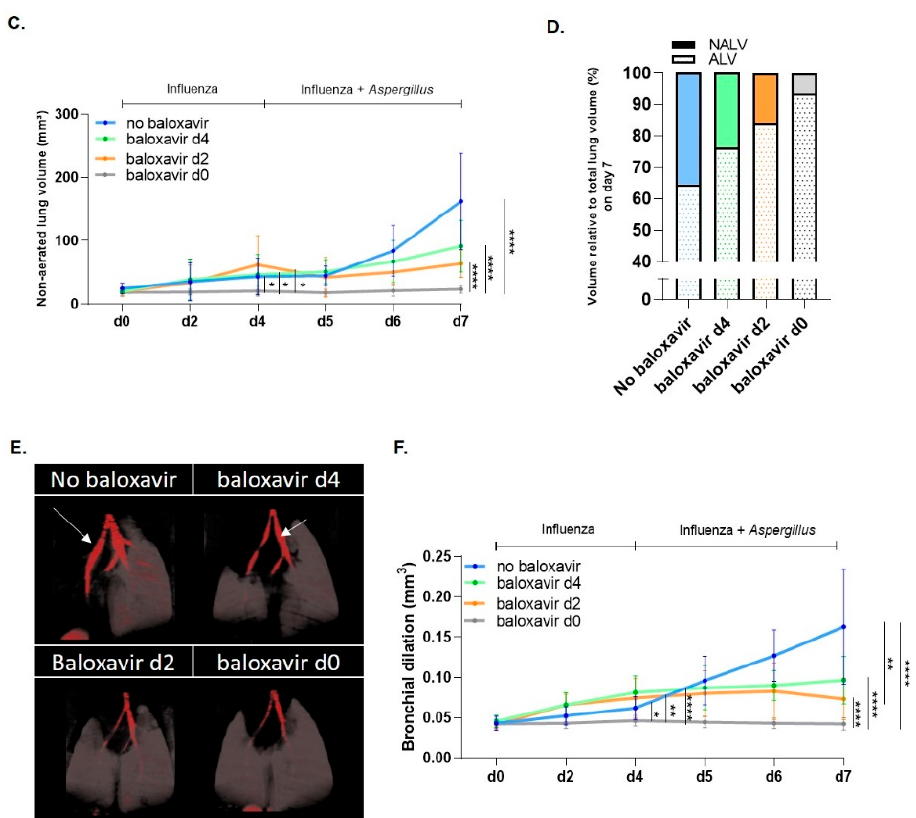
Figure 2. Baloxavir marboxil treatment reduces viral and viral-fungal pulmonary pathology and bronchial dilation. ( A ) Longitudinal three-dimensional (3D) visualization of aerated lung volume acquired with µ CT. Red: aerated lung tissue, Black arrows point at pulmonary infiltrates/lung pathology and dashed arrow to bronchial dilation. ( B ) Heatmap representation of lung severity scores based on transverse lungs µ CT images of non-treated (sham, no baloxavir), baloxavir marboxil from day 4, baloxavir marboxil from day 2 and baloxavir marboxil from day 0 treated mice. Red: severe pulmonary lesions, orange: moderate pulmonary lesions, green: no pulmonary lesions. ( C ) Graph represents longitudinal µ CT-derived biomarker “non-aerated lung volume” (pulmonary lesions) of immunocompetent influenza/ Aspergillus co-infected mice that received no baloxavir (sham, blue, n = 10 mice), baloxavir marboxil treatment-onset from day 4 (green, n = 10 mice), baloxavir marboxil treatment-onset from day 2 (orange, n = 10 mice) and baloxavir marboxil treatment- onset from day 0 (grey, n = 10 mice). ( D ) µ CT-derived biomarkers: non-aerated lung volume and aerated lung volume relative to total lung volume on day 7 of non-treated (sham, no baloxavir, blue, n = 10 mice), baloxavir marboxil from day 4 (green, n = 10 mice), baloxavir marboxil from day 2 (orange, n = 10 mice) and baloxavir marboxil from day 0 (grey, n = 10 mice). ( E ) Longitudinal 3D visualization of aerated lung volume acquired with µ CT. Grey: aerated lung tissue, Red: trachea with arrow bronchial dilation. ( F ) Quantification of bronchial dilation determined by manually delineation of the region of interest (ROI) of the airways of mice receiving no baloxavir marboxil (sham, blue, n = 10 mice), baloxavir marboxil treatment-onset from day 4 (green, n = 10 mice), baloxavir marboxil treatment-onset from day 2 (orange, n = 10 mice) and baloxavir marboxil treatment-onset from day 0 (grey, n = 10 mice). Statistical analysis for longitudinal graph: two-way ANOVA with Tukey’s multiple comparisons test repeated measurements performed from day 0 until day 4 (influenza infection) and day 4 until day 7 (influenza- Aspergillus co-infection). Differences were considered significant if p was smaller or equal to 0.05. * p < 0.05, ** p < 0.01 **** p < 0.0001. n values represent the number of animals. Data are represented as mean ±